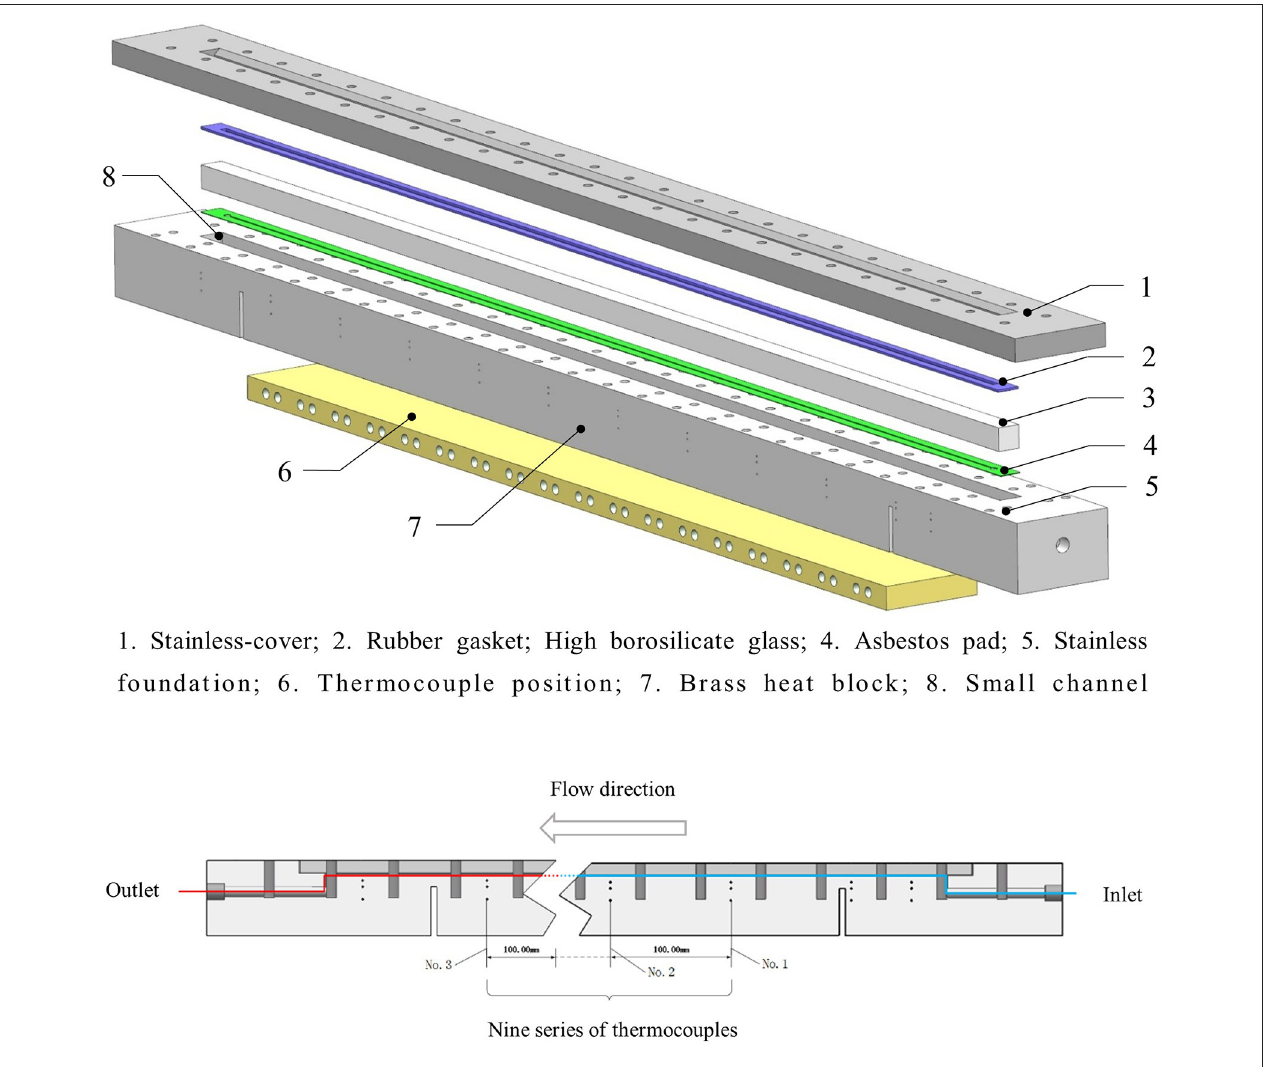
FIGURE 2 | The schematic diagram of the test